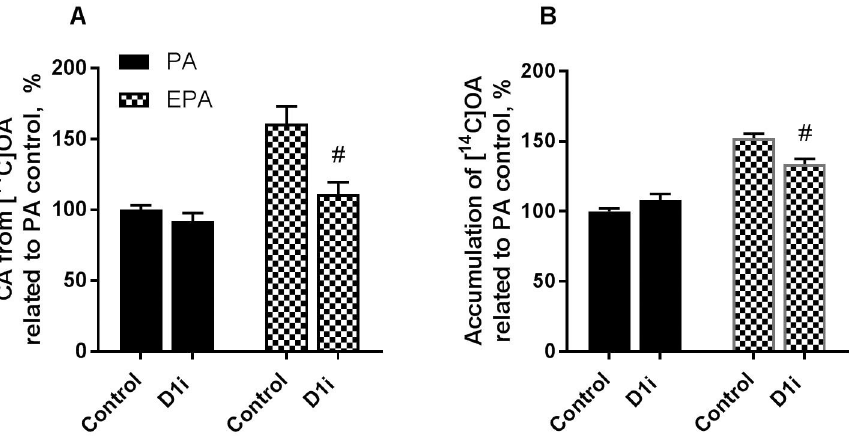
Fig 6. Effect of DGAT1 inhibitor on cell-associated and accumulated oleic acid. (A) Human myotubes were treated with fatty acids (100 μ M EPA or PA) for 24 h. Cell-associated [ 14 C]OA (100 μ M) was measured after 4 h with and without DGAT1 inhibitor (D1i, A922500, 1 μ M). Results represent mean ± SEM, from experiments with 4 different donors and 4–8 parallels (n = 26). Cell-associated PA (100%): 53.8 ± 4.0 nmol/mg cell protein. (B) Human myotubes were grown and differentiated in 96-well ScintiPlate tissue culture plates. On day 6 of differentiation the myotubes were treated with a mixture of 100 μ M fatty acids for 24 h and cell-associated radioactivity was measured during 24 h by SPA. The mixture was trace amounts of [ 14 C]OA (9 μ M) and non-labeled PA or EPA (91 μ M). DGAT1 inhibitor was also added for 24 h. Results represent mean ± SEM from experiments with 3 different donors and 8 parallels (n = 24). Accumulated PA (100%): 156 ± 13.8 nmol/mg cell protein. #p < 0.05 for D1i inhibitor vs. control in EPA- treated cells (t-test). EPA, eicosapentaenoic acid; PA, palmitic acid; D1i, diacylglycerol acyltransferase 1